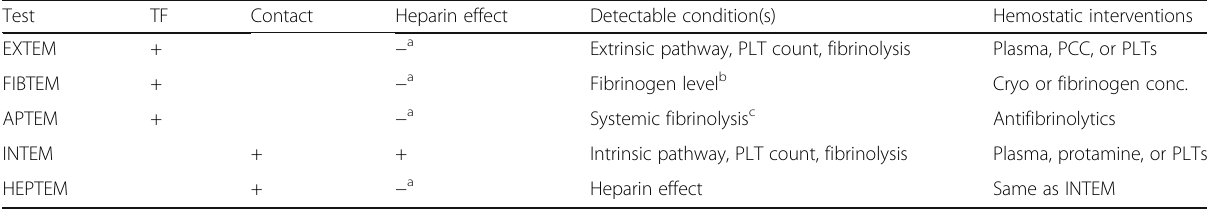
Table 1 Types of assays on rotational thromboelastometry Test TF Contact Heparin effect Detectable condition(s) Hemostatic